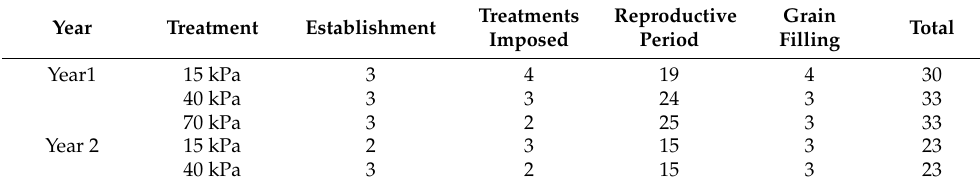
Table 3. Number of irrigation events during various growth stages in both